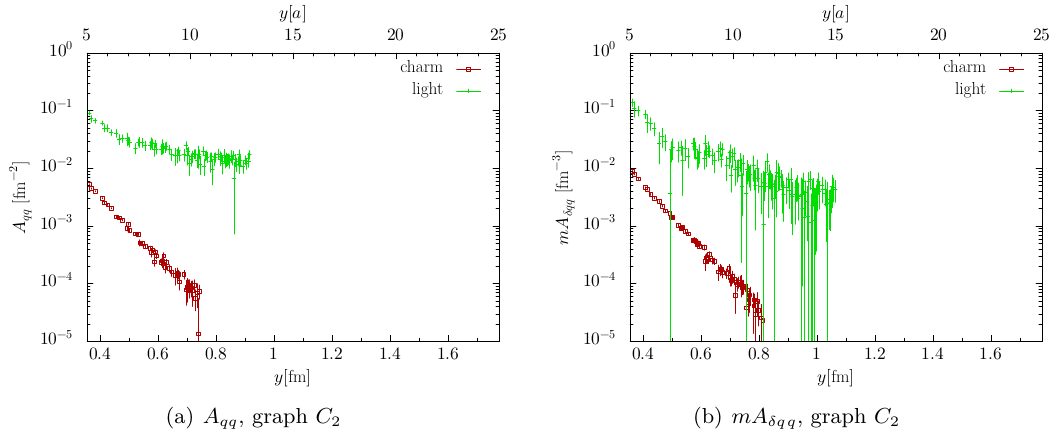
Figure 19 . Mass dependence of twist-two functions for graph C 2